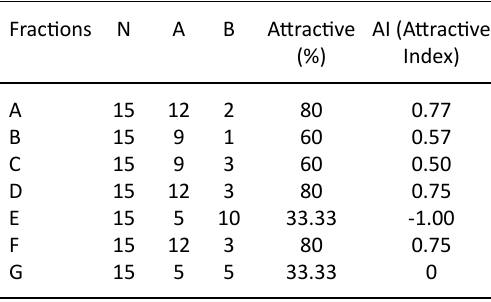
Table 3. Biological Activity Assays of the fractions (A-G) in the warehouse ( S. oryzae L) samples